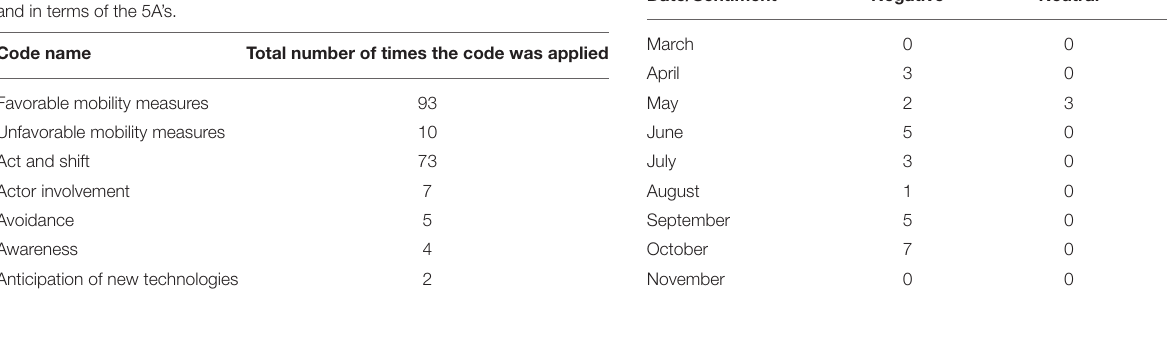
TABLE 3 | Actors involved in the articles and their